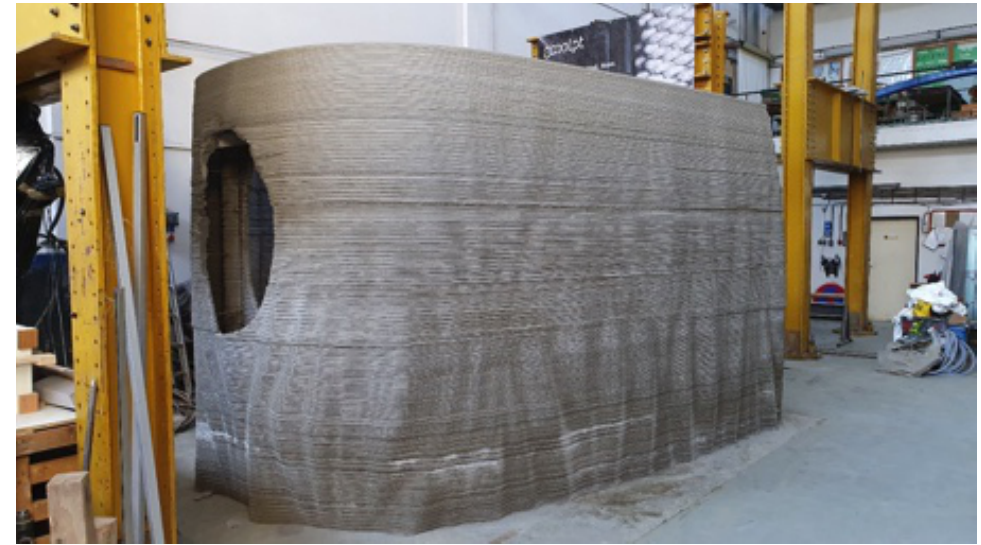
Figure 6. Printed segment of the